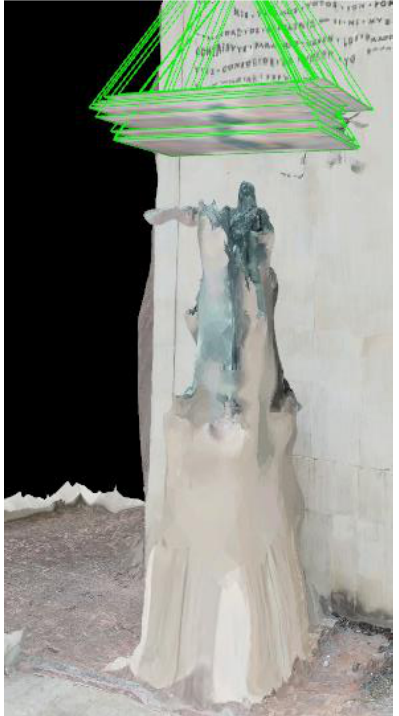
Figure 18: Result of the 3D reconstruction of the sculpture of Equestrian Bolivar.